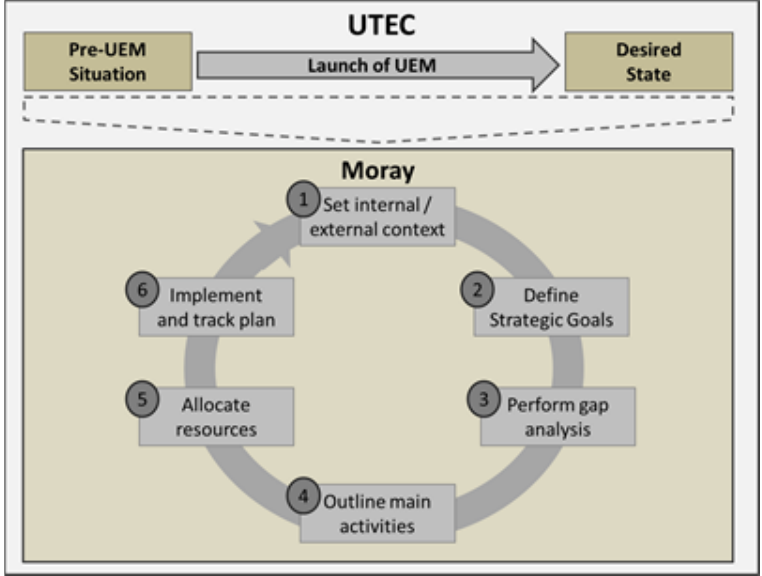
Fig. 2. Moray´s strategic planning process for the successful implementation of UEM. The benchmarking analysis and internal diagnosis (step 1) led to the definition of goals (step 2) and a follow-on gap analysis (step 3). The initial main activities (i.e. pilot projects) were focused on bridging these gaps (step 4) and were planned carefully by allocating the necessary resources to attain quick wins (step 5). The final step (6) consisted of im- plementing the initial plan and tracking the impact and results on the implementation of UEM. The process is iterative for continuous improvement of Moray and UEM at